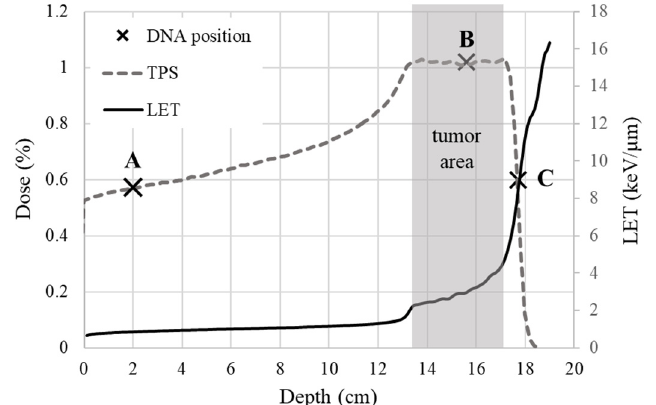
Figure 3. General treatment plan dose distribution: the % dose (dashed line) deposited when irradiating a volume of a hypothetical tumor of 4 cm thickness and approximately 13 cm under the skin (grey tumor area), as exported by TPS and the equivalent LET change over depth in water (solid line). The three positions of DNA irradiation (×) along the treatment plan are also marked: the beam entrance (A), the middle of SOBP plateau (B) and the SOBP fall-off (C) . Table 1. Irradiation parameters along the therapeutic proton SOBP . Irradiation Position Depth in PMMA (cm) LET (keV/ μ m) Energy Range (MeV)